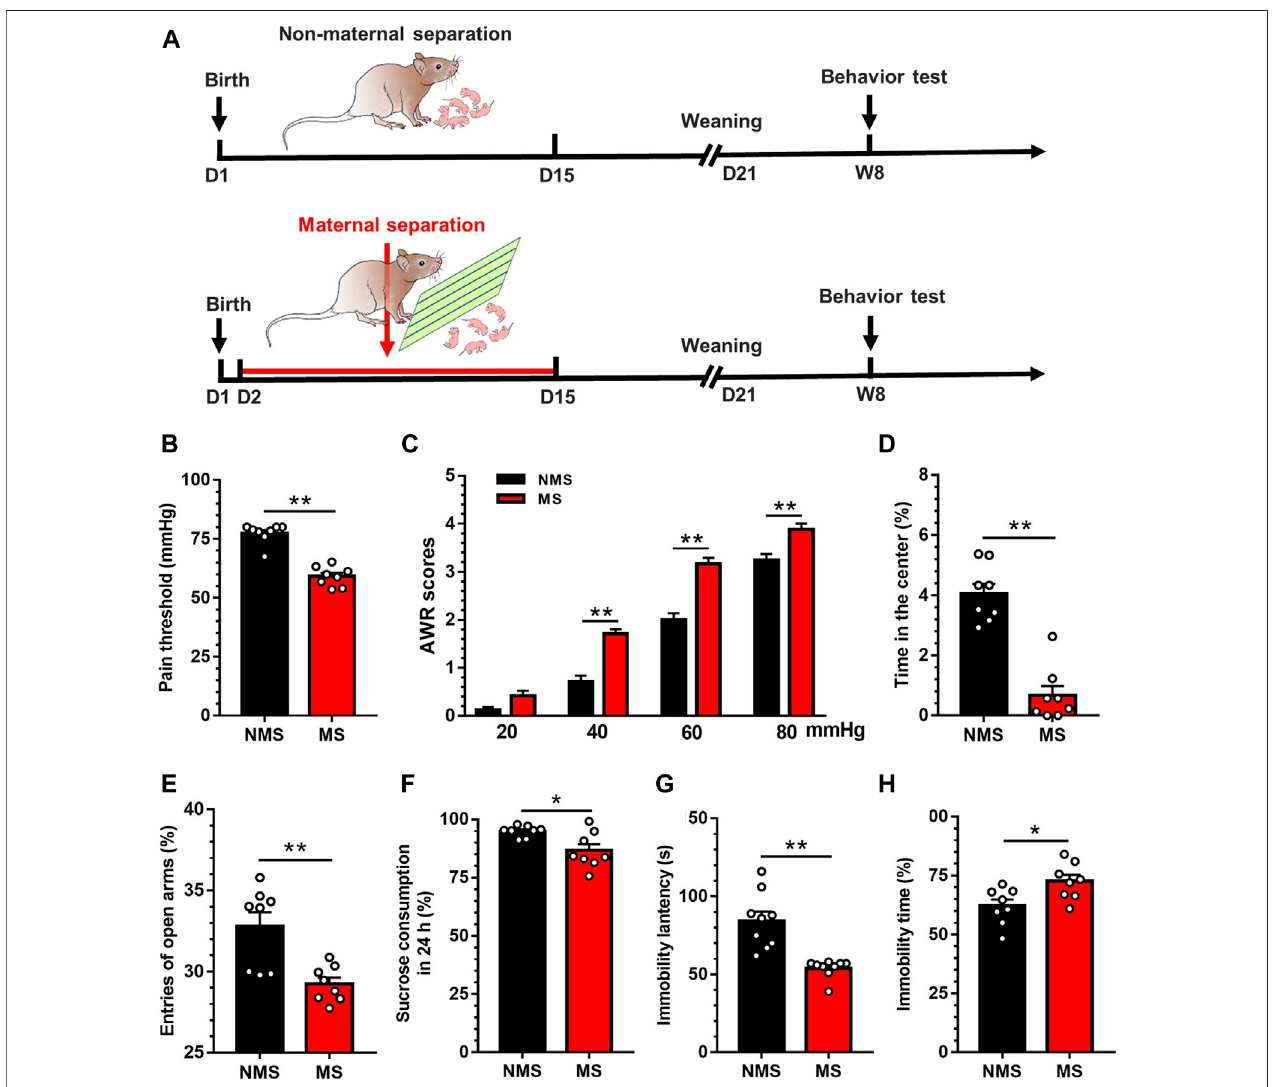
FIGURE 1 | Chronic visceral pain, anxiety- and depression-like behaviors were induced by MS in mice (A) The establishment of maternal separation model (B) Visceral pain threshold in MS group was decreased compared with NMS group ( n (cid:2) 8) (C) AWR scores in MS group were increased compared with NMS group ( n (cid:2) 8) (D) Durationinthecenterwassigni fi cantlydecreasedinMSgroupcomparedwithNMSgroup( n (cid:2) 8) (E) Thetimesofentryintoopenarmswassigni fi cantlydecreasedin MS group compared with NMS group ( n (cid:2) 8) (F) The sucrose consumption in MS group was signi fi cantly decreased compared with NMS group in 24h ( n (cid:2) 8) (G) ThelatencyofimmobilityinMSgroupwassigni fi cantlydecreasedincomparisonwithNMSgroupinforcedswimmingtest( n (cid:2) 8) (H) TheimmobilitydurationinMSgroup was signi fi cantly increased compared with NMS group in forced swimming test ( n (cid:2) 8). Data are presented as the mean ± S.E.M. *p < 0.05, ** p < 0.01 compared with NMS